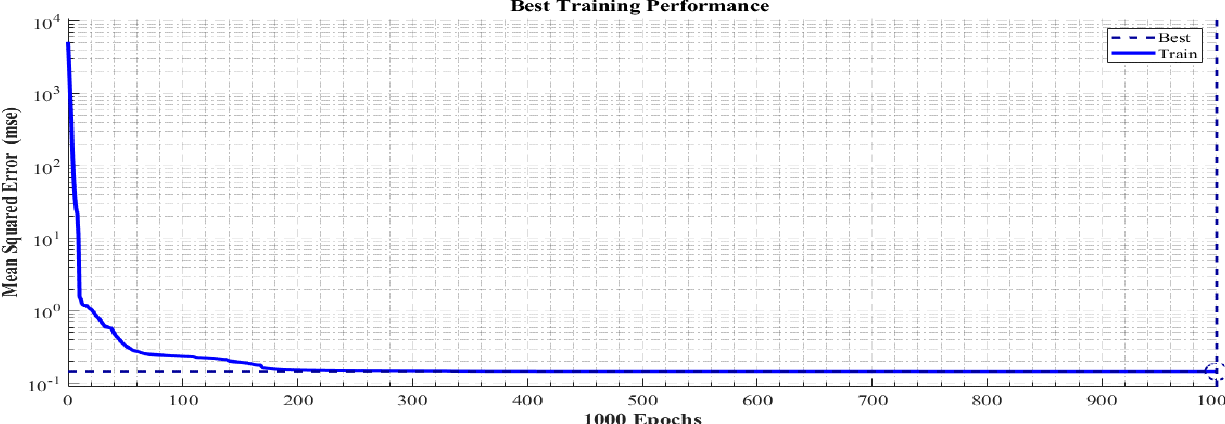
Figure 6 . Best HNN training performance